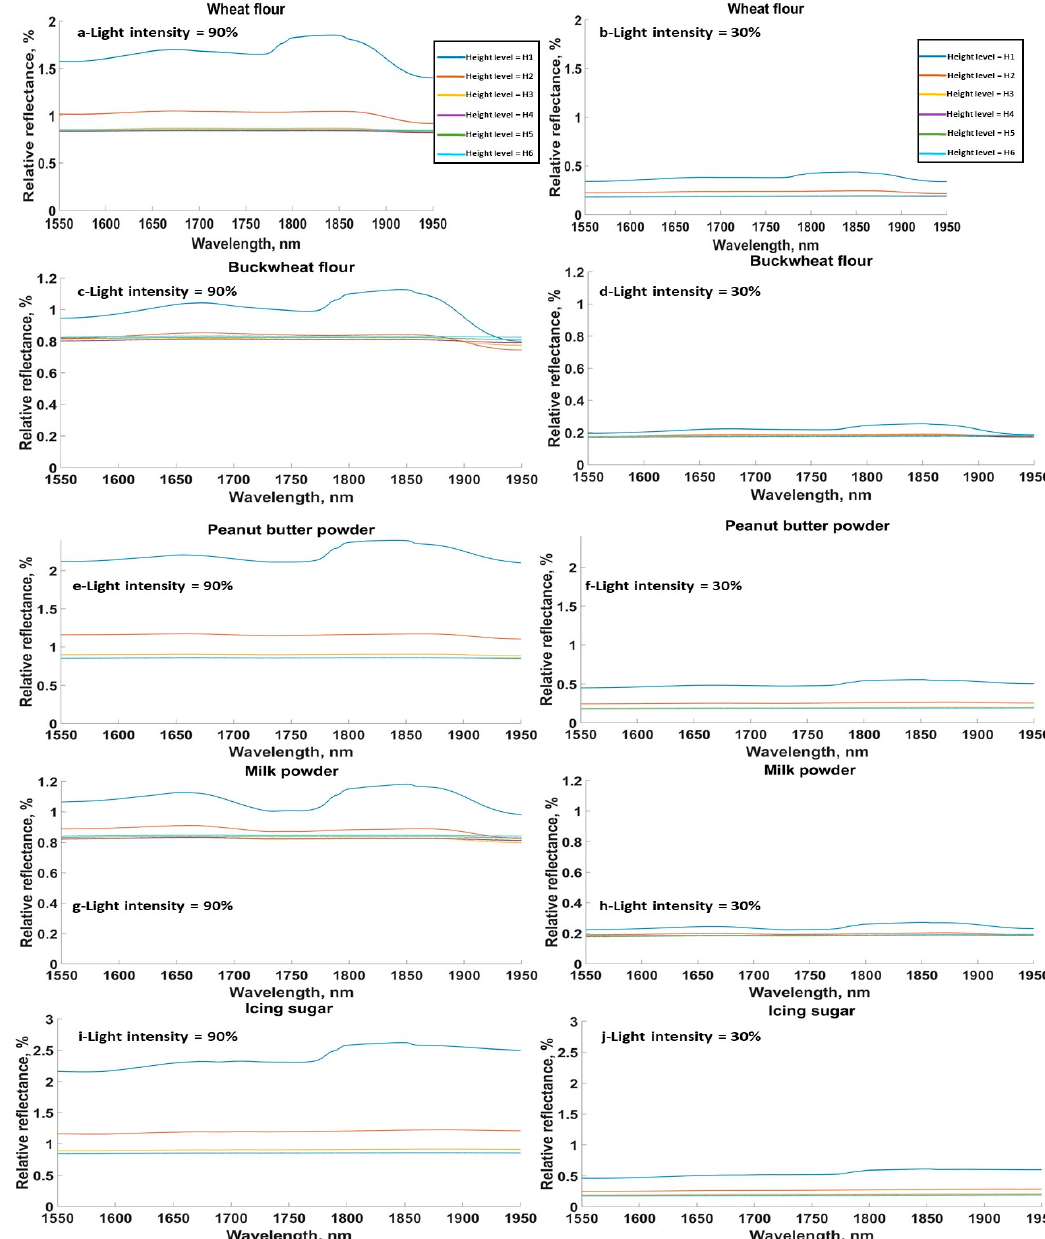
Figure 2. Relative reflectance for all height levels and the minimum and maximum light intensities, 90% and 30%, for ( a , b ) wheat flour, ( c , d ) buckwheat, ( e , f ) peanut butter powder, ( g , h ) milk powder, ( i , j ) icing sugar. Height levels: H1 = 3 cm, H2 = 4.5 cm, H3 = 6 cm, H4 = 7.5 cm, H5 = 9 cm, H6 = 10.5 cm.